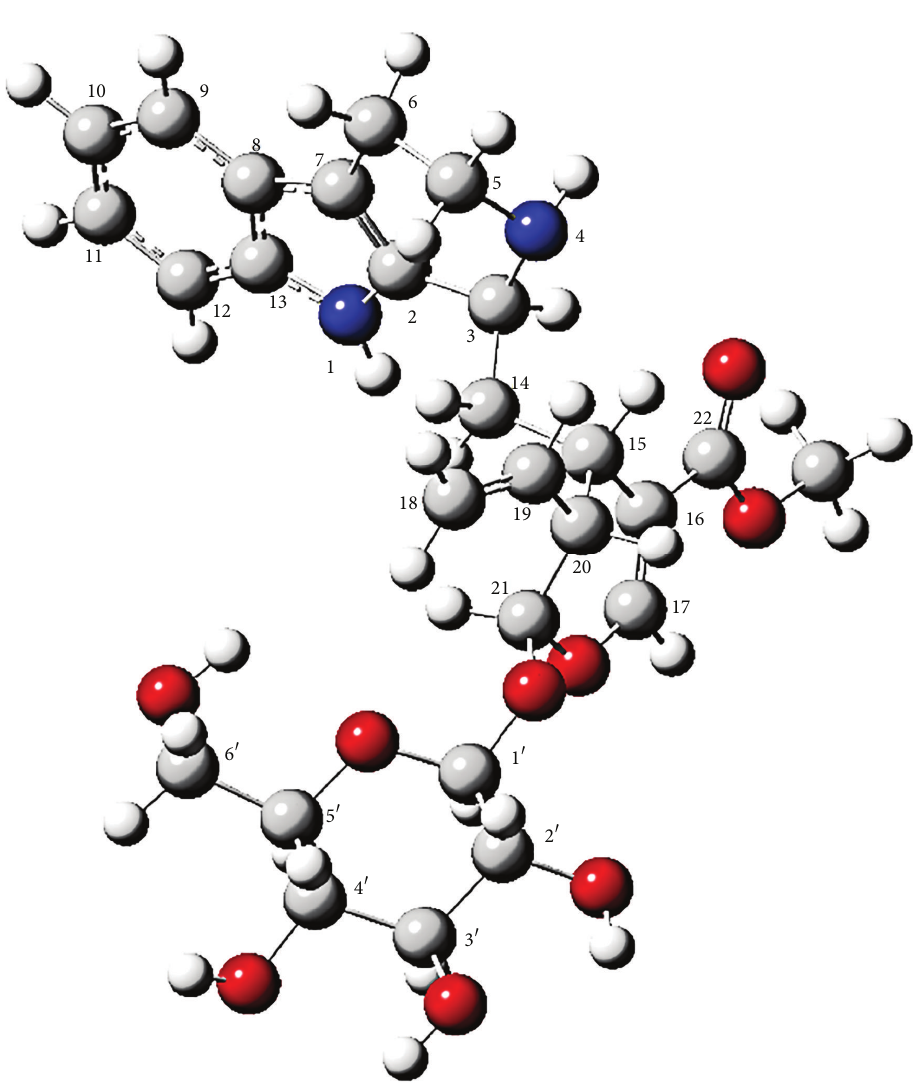
Figure 2: The optimized geometry of strictosidine with the scheme of atom